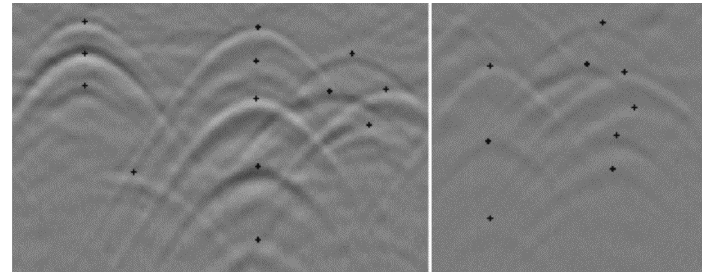
Figure 10. Reliable classification results in case of interfering hyperbolas.